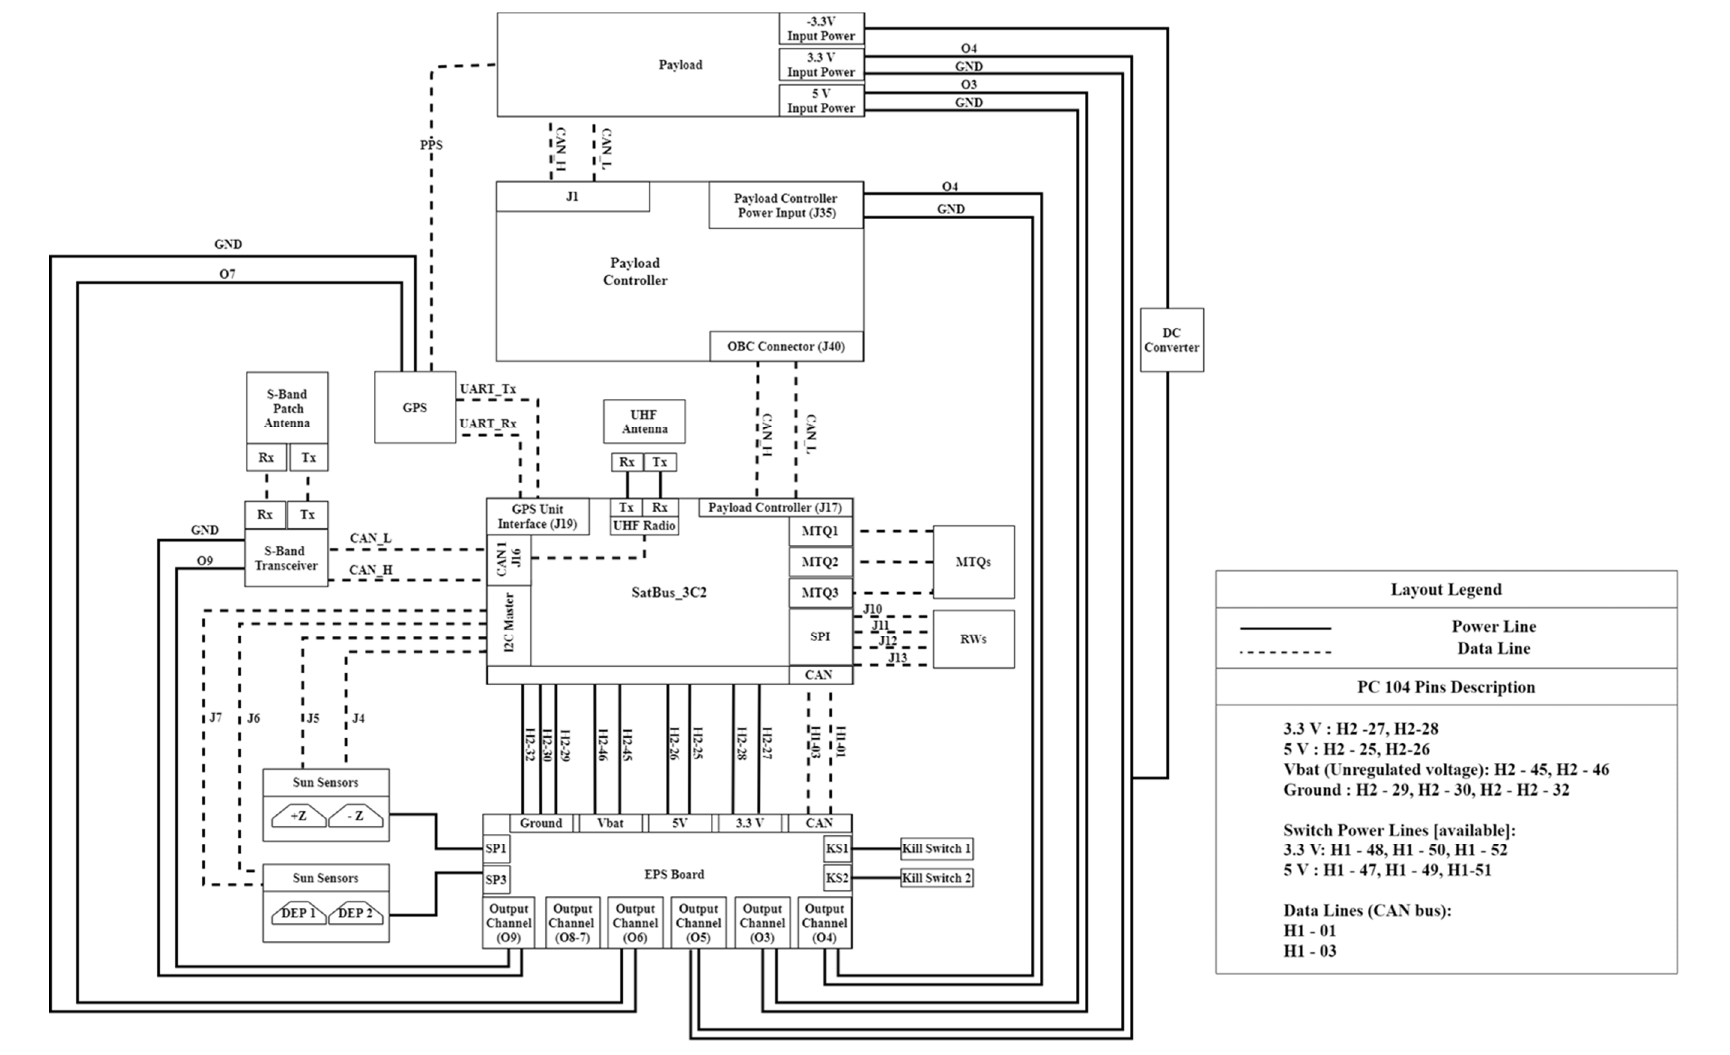
Figure 4. Pin level diagram of Light-1.